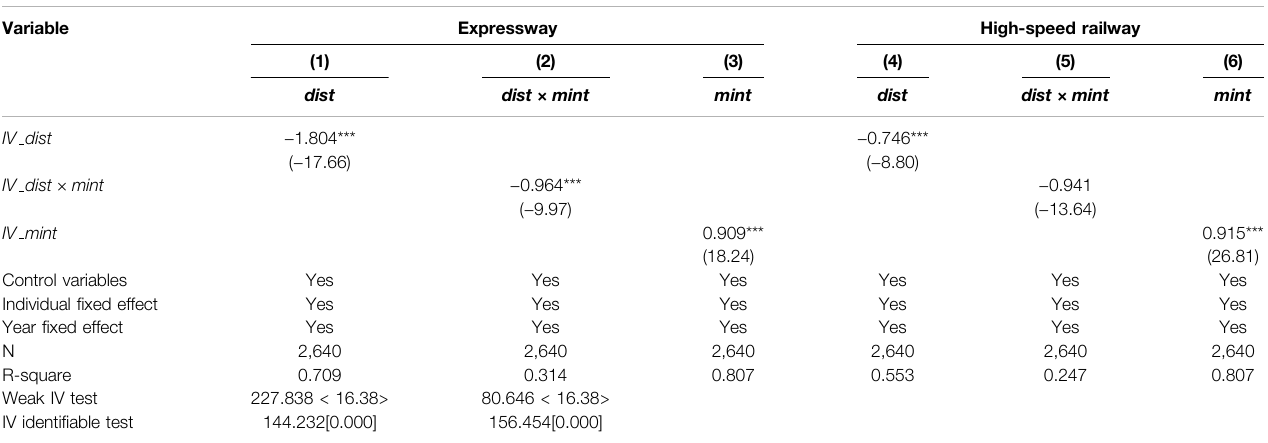
TABLE 7 | The fi rst stage regression results of instrumental